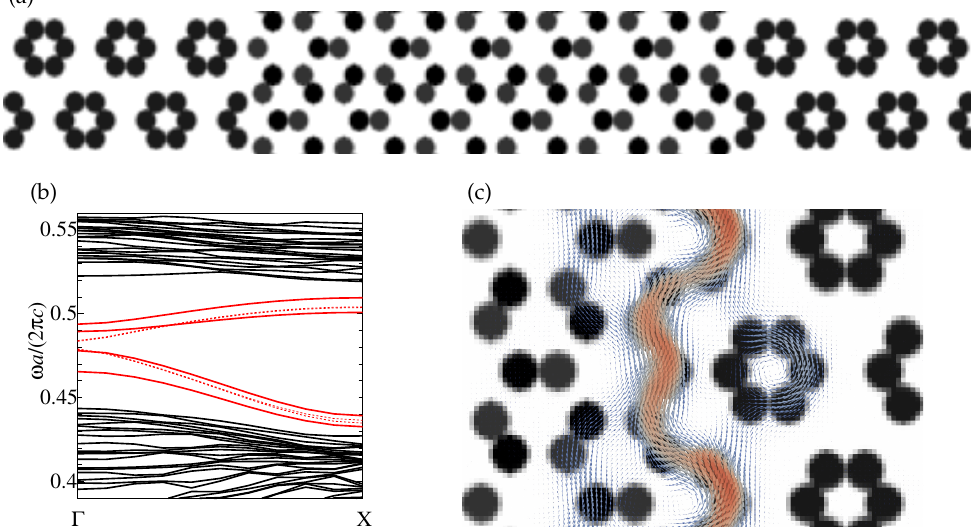
Figure 5. ( a ) Unit cell of a 2D superlattice composed of quasi-topological and non-topological photonic crystals in Figure 4. ( b ) Projected band diagram of TM modes of ( a ). Edge modes are emphasized in red. The red-dotted lines show the edge modes where the relative permittivities of the dark gray and black rods in the middle part are set to 10. The vertical axis represents dimensionless frequency ω a / ( 2 π c ) . ( a : lattice constant and, c : speed of light) ( c ) Energy flux density of an edge mode ( ω a / ( 2 π c ) = 0.455) belonging to the lowest branch (the lowest red curve) in ( b